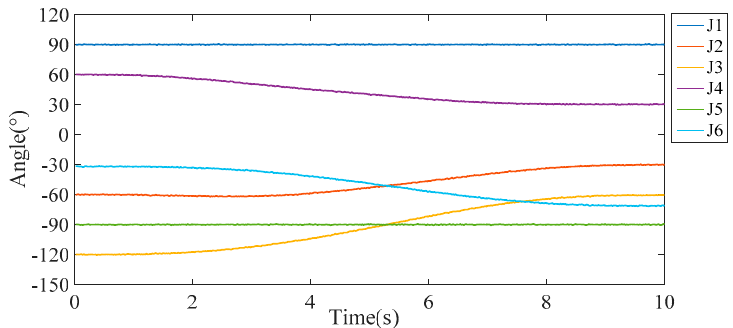
Figure 23. The joint angles of the climbing mechanism in the experiment.